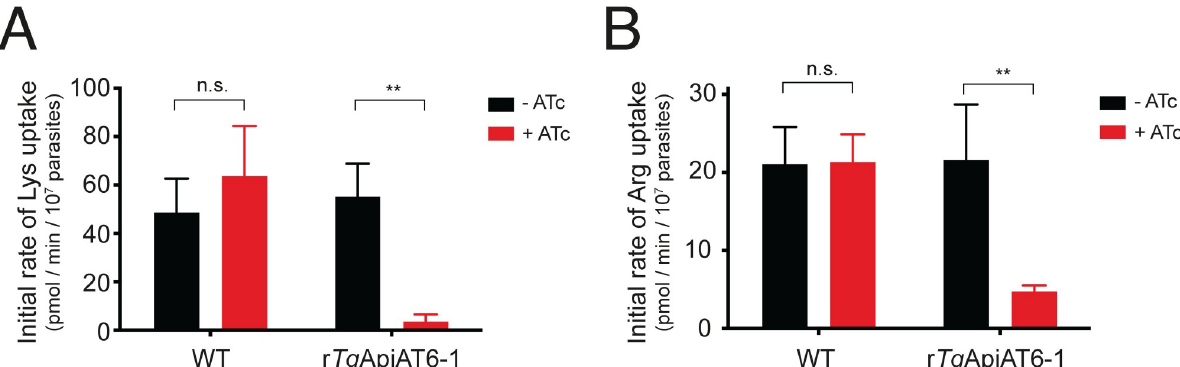
Fig 4. Tg ApiAT6-1 mediates uptake of Lys and Arg in T . gondii parasites. A-B . Initial rate of Lys (A) and Arg (B) uptake in WT and r Tg ApiAT6-1 parasites cultured in DME in the absence (black) or presence (red) of ATc for 2 days. Uptake was measured in 50 μ M unlabelled Lys and 0.1 μ Ci/ml [ 14 C]Lys (A) or 80 μ M unlabelled Arg and 0.1 μ Ci/ml [ 14 C]Arg (B) . Initial rates were calculated from fitted curves obtained in time-course uptake experiments (S5 Fig). Data represent the mean initial uptake rate ± S.D. from three independent experiments.( �� , P = 0.01; n.s. not significant; ANOVA with Sidak’s multiple comparisons